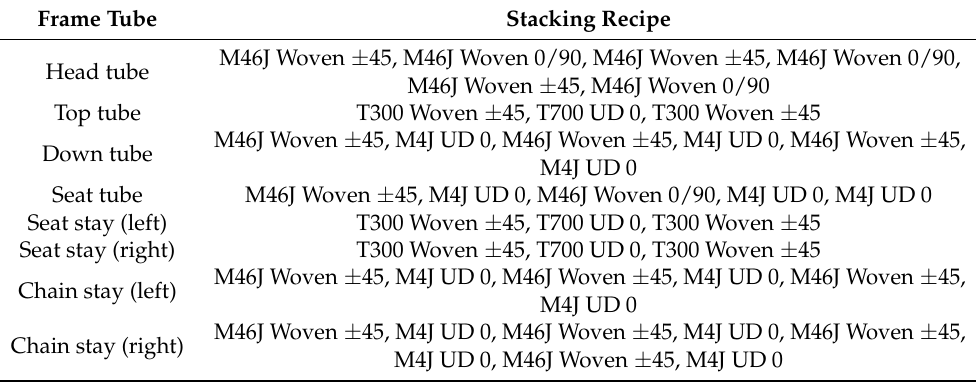
Table 9. Stacking scenario 6.